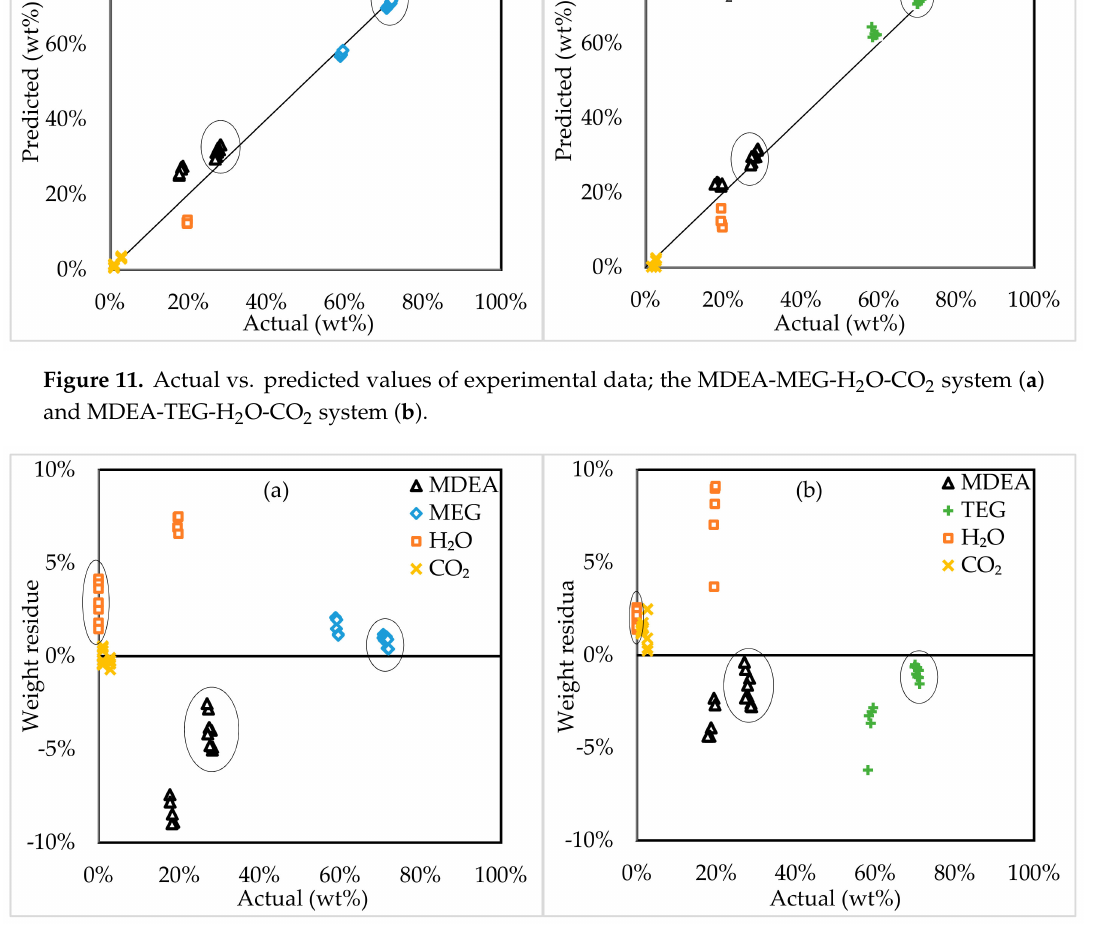
Figure 12. Weight residual of experimental data; the MDEA-MEG-H 2 O-CO 2 system ( a ) and MDEA-TEG-H 2 O-CO 2 system ( b